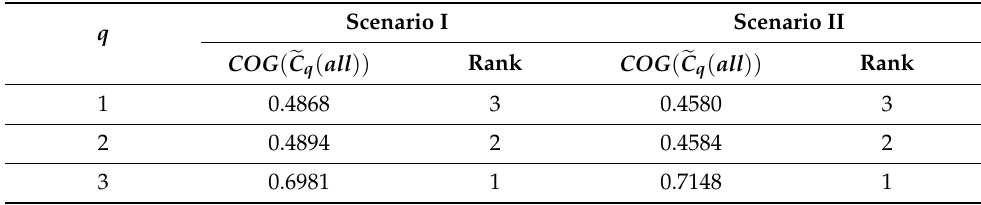
Figure 11. The aggregation results (scenario II). Table 8. Defuzzification results.